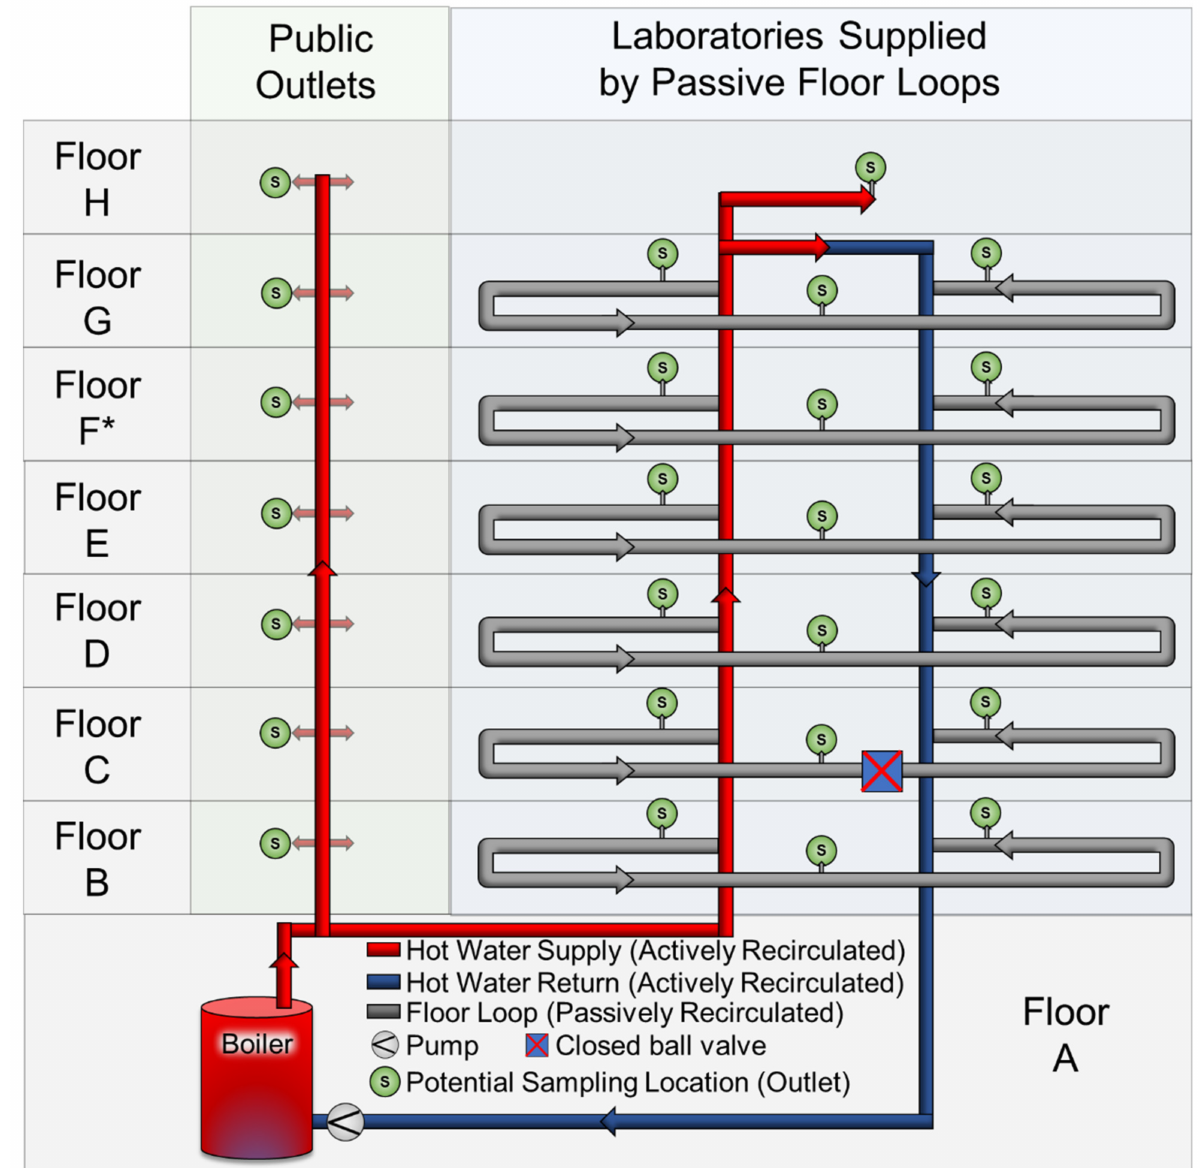
Figure 1. Simplified building plumbing schematic of the hot water system. The main boiler (1000